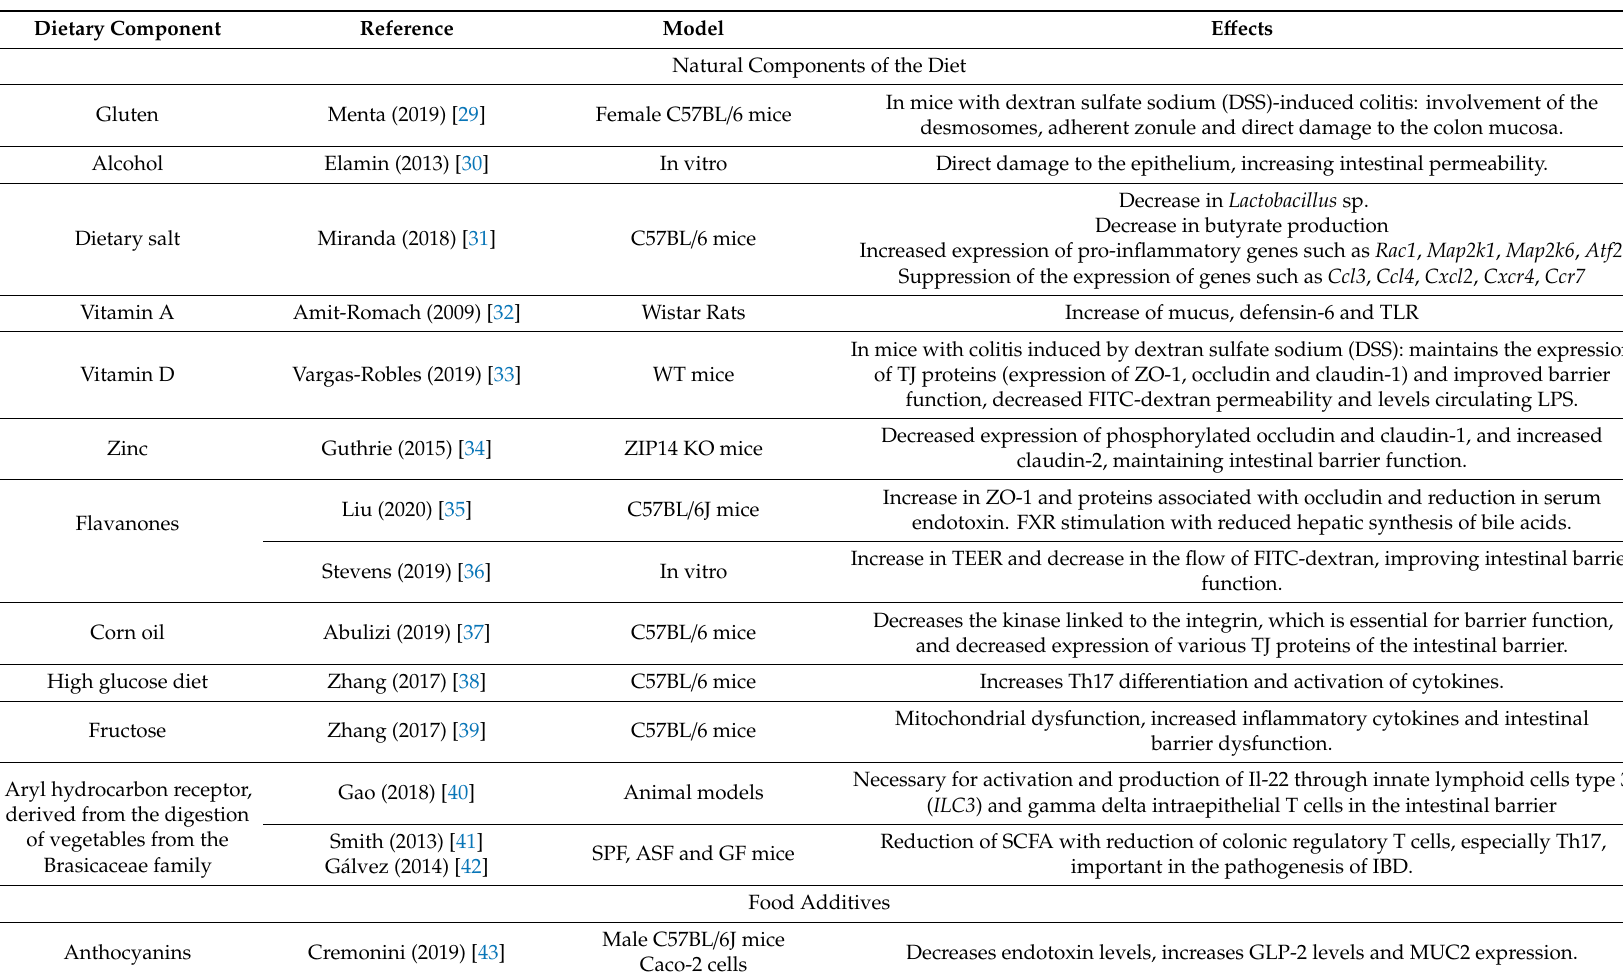
Table 1. Dietary factors that potentially a ff ect intestinal barrier mechanisms and host immunity. (Updated from reference